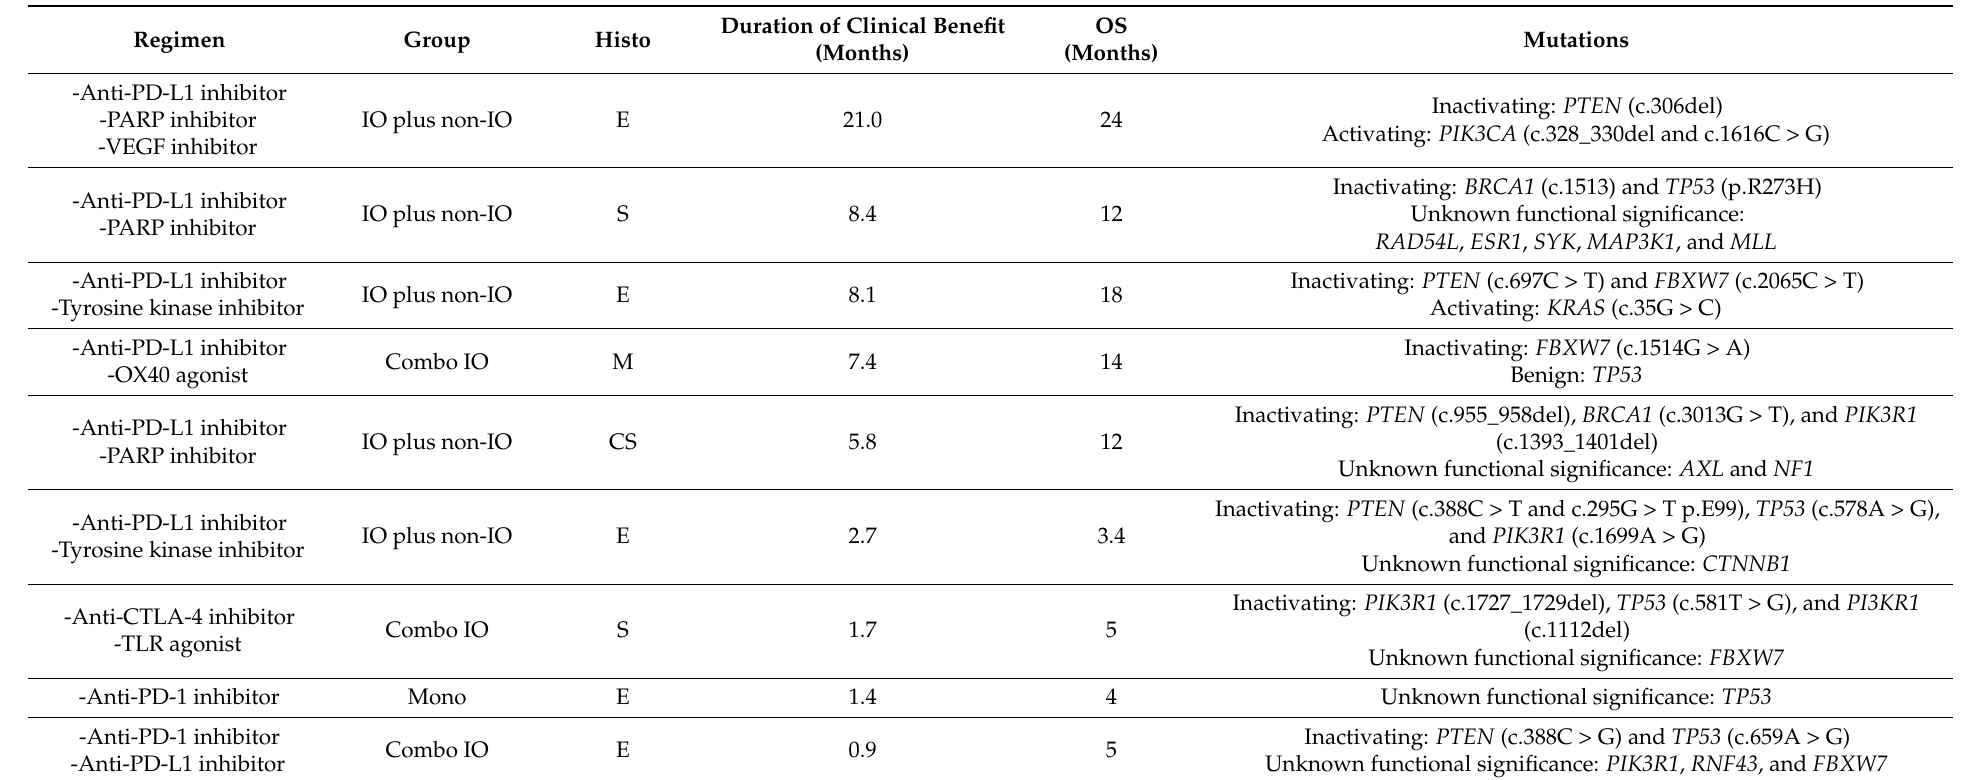
Table 3. Patients who had disease control on